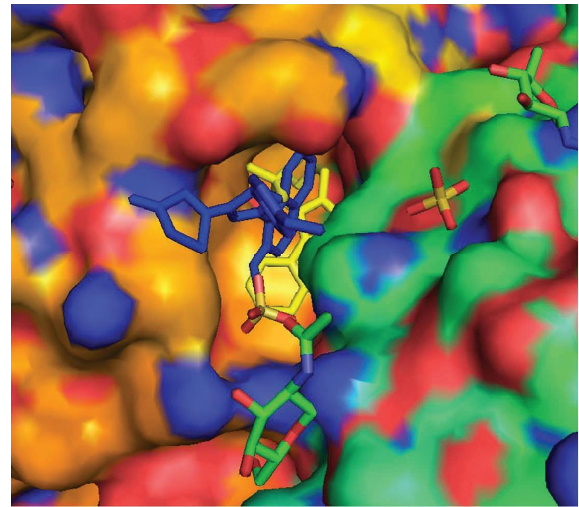
Figure 6: Compound 6 (blue color) residing in the binding site superimposed with resiquimod (yellow color) contained in 5 gmh ·